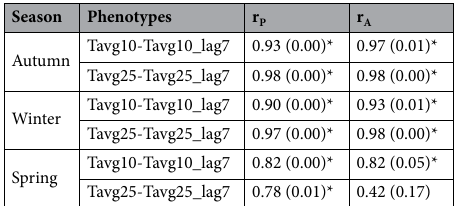
Table 5. Correlation estimates between daily and cumulative animal resilience phenotypes by lambing season (standard errors in parentheses). Tavg10, Tavg25: milk yield change by 1 °C temperature change at 10 °C and 25 °C on the milk test date, respectively; Tavg10_lag7, Tavg25_lag7: milk yield change by 1 °C cumulative average air temperature change during the week preceding the milk test date, r P Phenotypic correlation between different seasonal resilience phenotypes, r A Genetic correlation between different seasonal resilience phenotypes. Estimates significantly different from zero (P < 0.01) are indicated with an